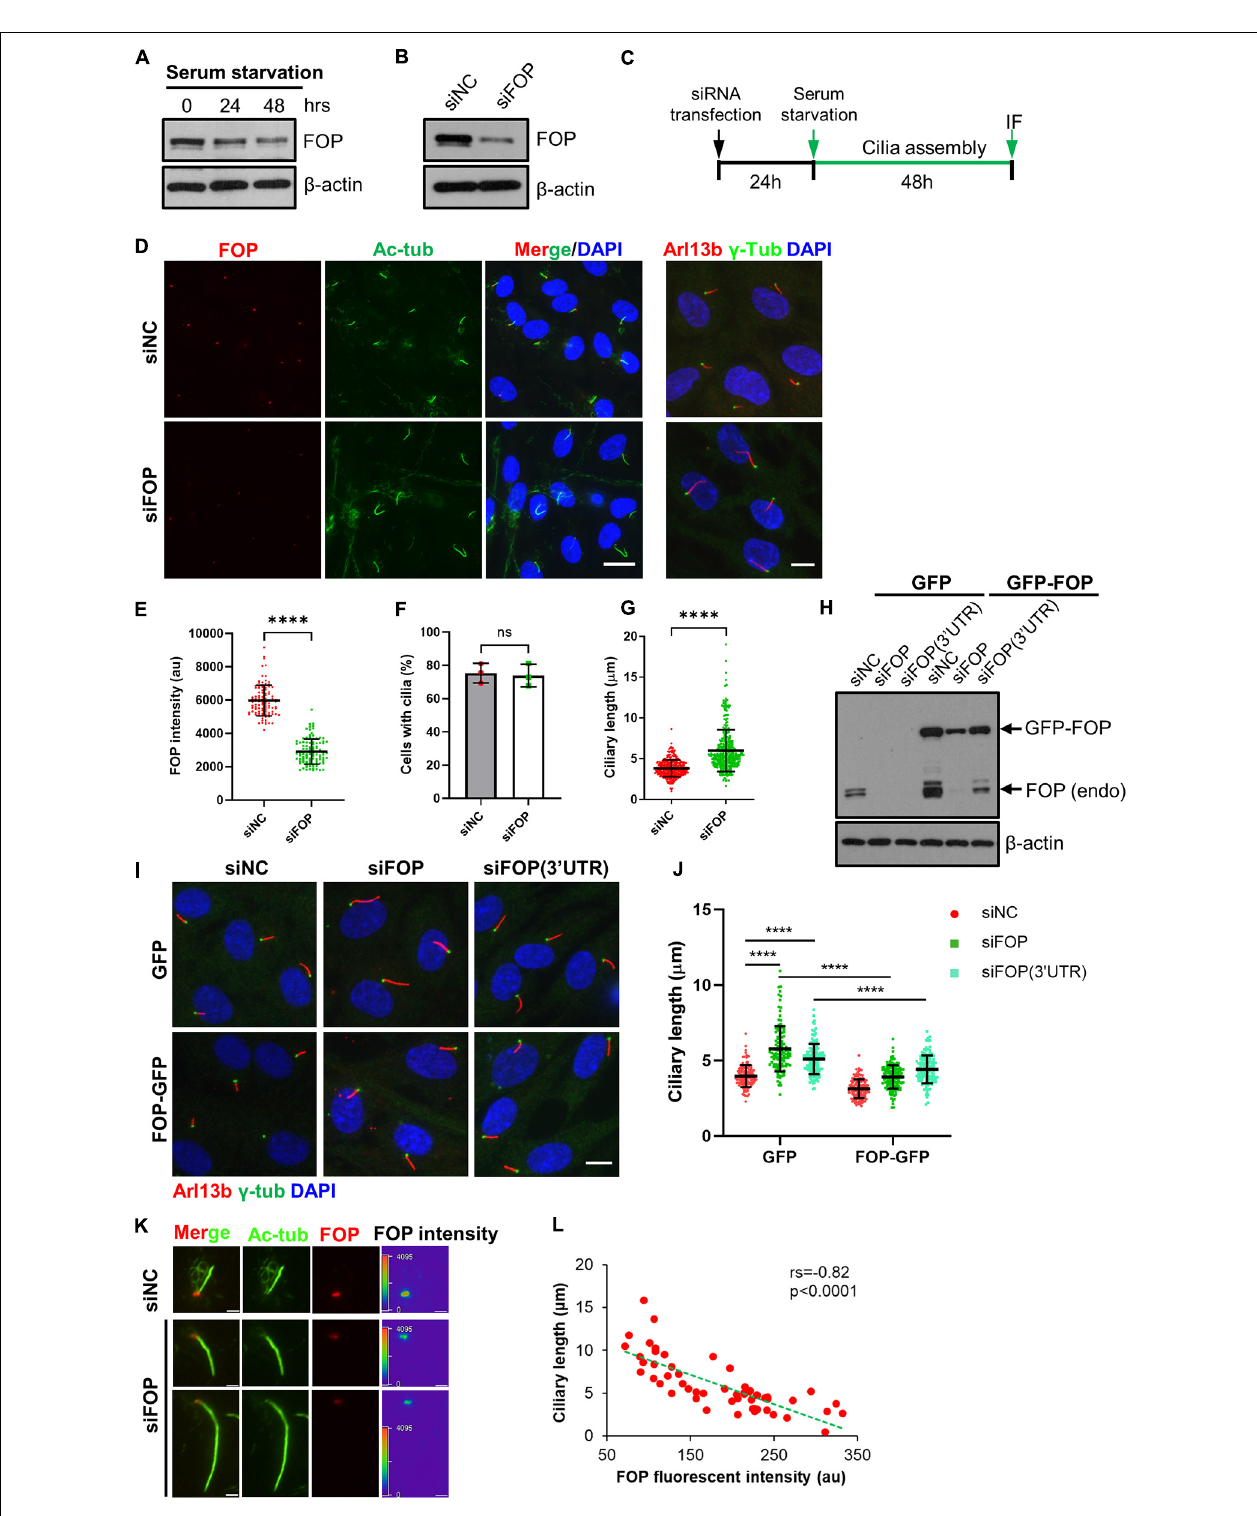
FIGURE 1 | FOP negatively regulates primary cilia growth. (A) The protein levels of FOP decrease during cilia assembly. RPE1 cells were serum-starved to induce primary cilia formation. The levels of FOP during cilia assembly were determined by immunoblotting at 0, 24, and 48 h. (B) RPE1 cells were transfected with negative control siRNA (siNC) or FOP siRNAs (siFOP). The knockdown efficacy was determined by immunoblotting at 72 h post-transfection. (C) Schematic diagram of the experimental design for the cilia assembly assay. (D) RPE1 cells transfected with siNC or FOP siRNAs were serum-starved and immunostained for FOP